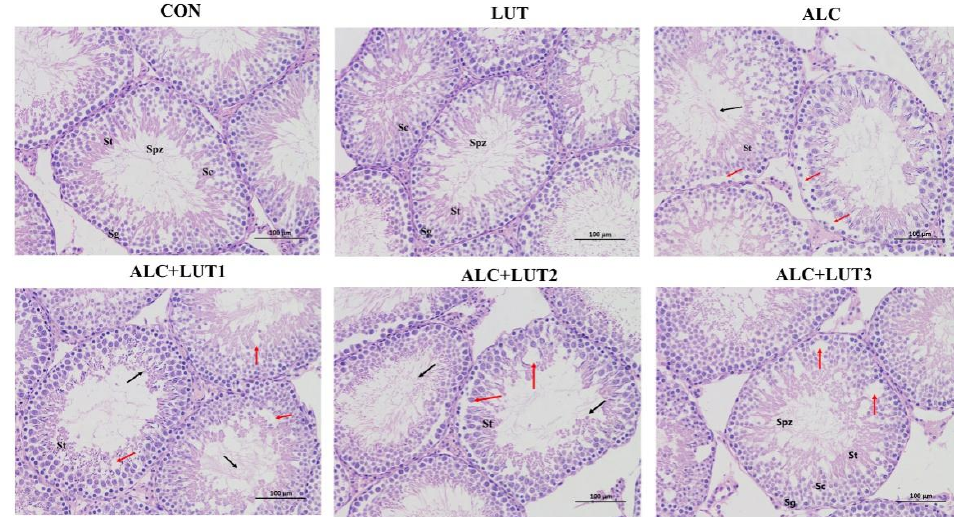
Figure 3. Morphological changes in testis tissue. CON: control group; LUT: lutein alone supplement group; ALC: alcohol model group; ALC + LUT1: alcohol + low-dose lutein group; ALC + LUT2: alcohol + medium-dose lutein group; ALC + LUT3: alcohol + high-dose lutein group; Sg (spermatogonia), ST (seminiferous tubule), SC (Sertoli cell), SPZ (sperm); black arrow (alcohol causes convoluted seminiferous tubule degeneration, causing Sertoli cells to fall off into the lumen of the convoluted seminiferous tubule), red arrow (seminiferous epithelium showing severe seminiferous tubule atrophy, including germ cell disorder and necrotic area). Sections were stained with hematoxylin and eosin (100×).